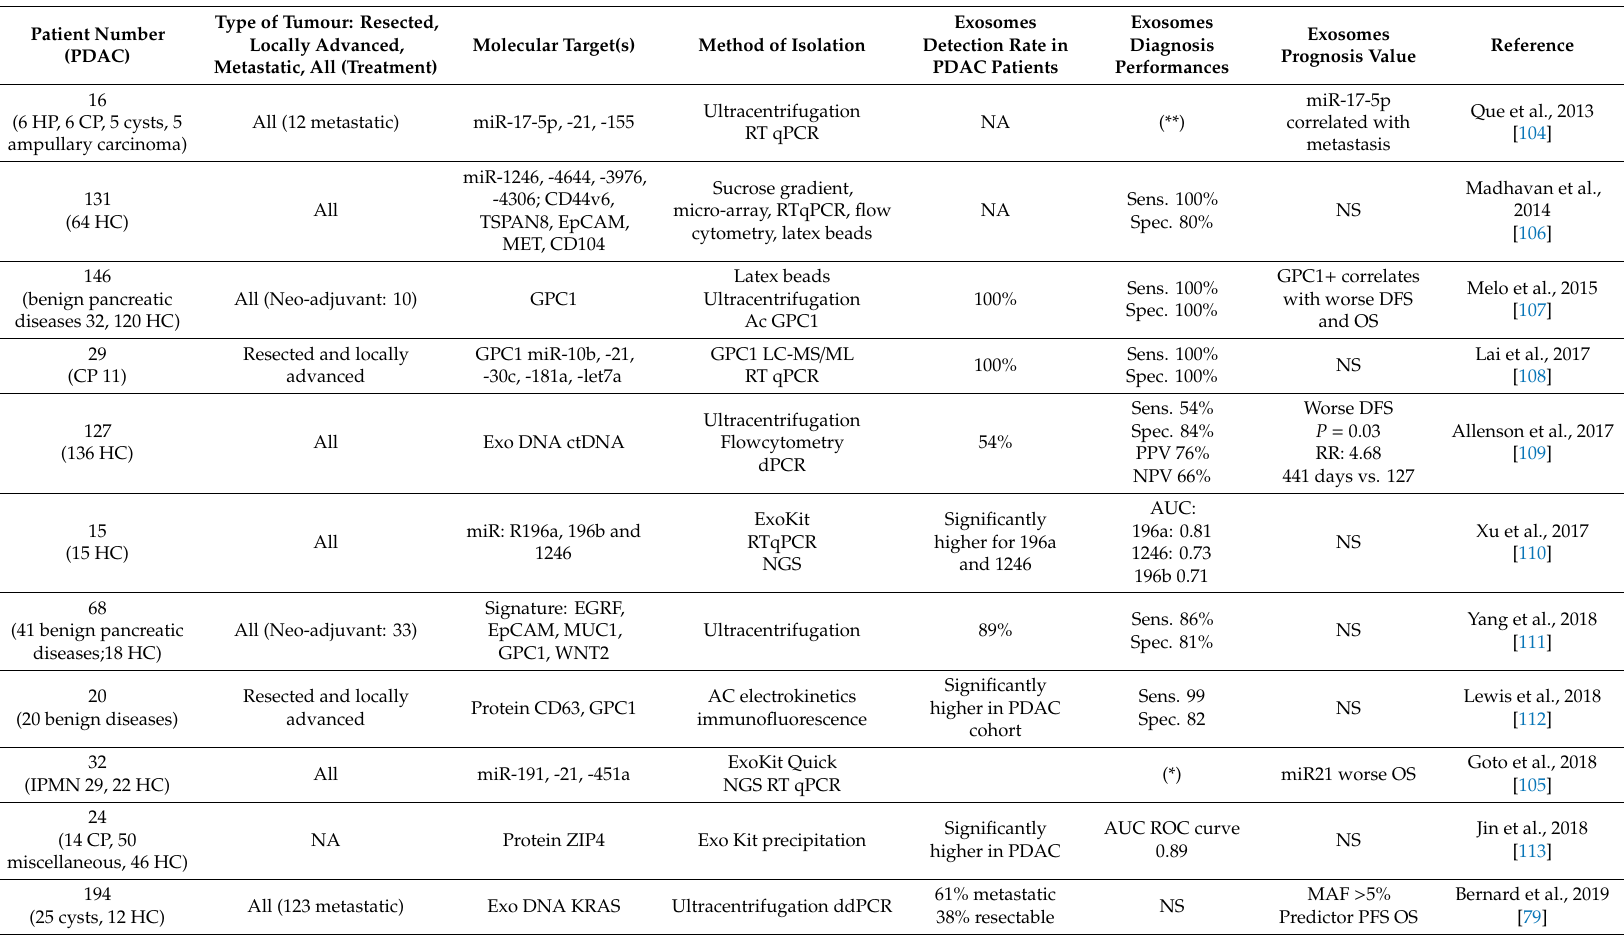
Table 3. Results of main clinical pilot studies assessing performances of exosome detection in